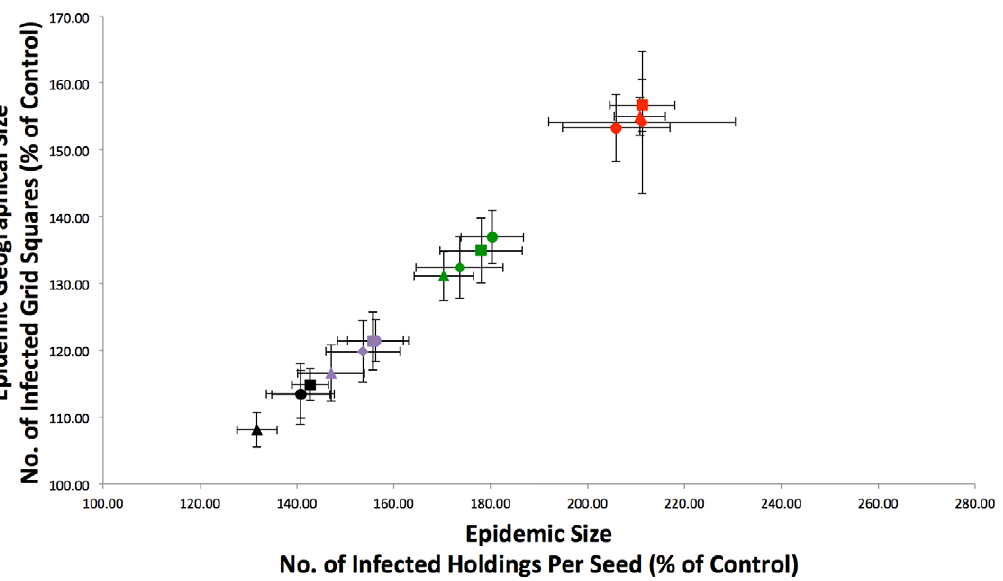
Figure 9. Comparison of epidemic sizes and geographical spread with different linked holdings. The model was run including CTS Chains, with the following distance limits on intra-Chain spread: No Limit (red), 50 km (green), 16 km (purple), and 8 km (black). Epidemic size (number of infected holdings per seed) and geographical size (number of infected grid squares per seed) were firstly transformed into percentages of the control epidemic size from the same time of year. Secondly, averages were then obtained for the four quarters of the year (Jan-Feb-Mar [squares], Apr-May-Jun [circles], Jul-Aug-Sep [triangles], Oct-Nov-Dec [diamonds]) giving four data points for each scenario. Error bars are associated with each quarterly average value that represent the 95% confidence intervals for that quarter, assuming a normal distribution and a standard deviation calculated from that quarter’s data.